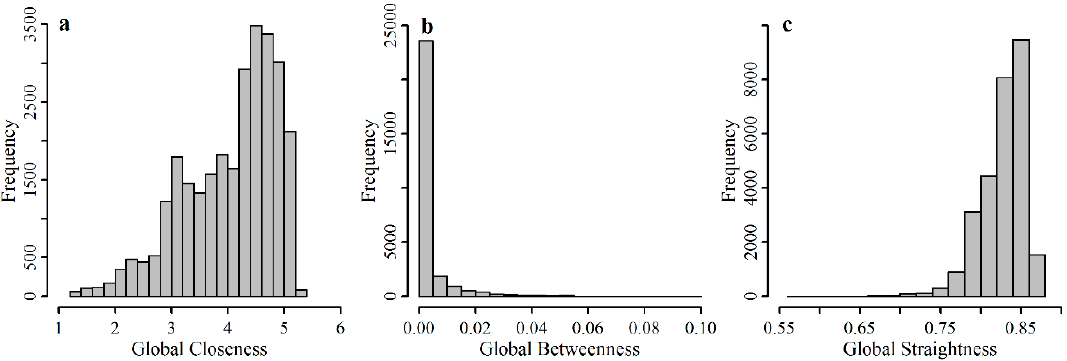
Figure 6. Frequency distribution of global centrality indicators at each node, global closeness ( a ), global betweenness ( b ), and global straightness ( c ).